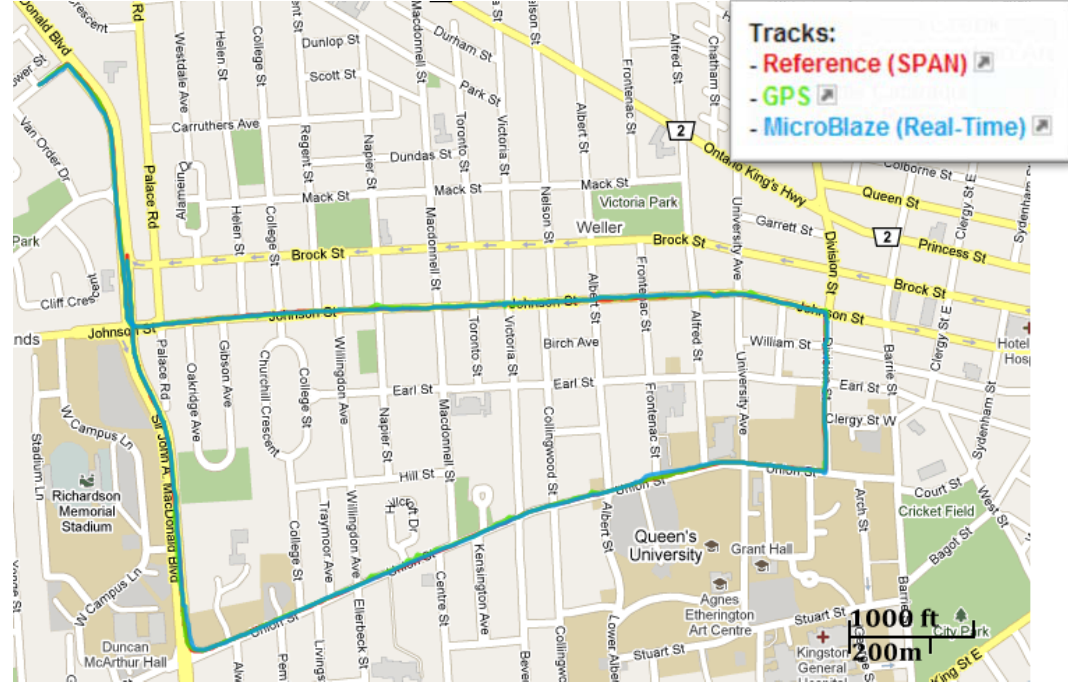
Figure 22. Land Vehicle Trajectory (1): Open Sky Area, with Minimum Natural Outages and no Simulated GPS